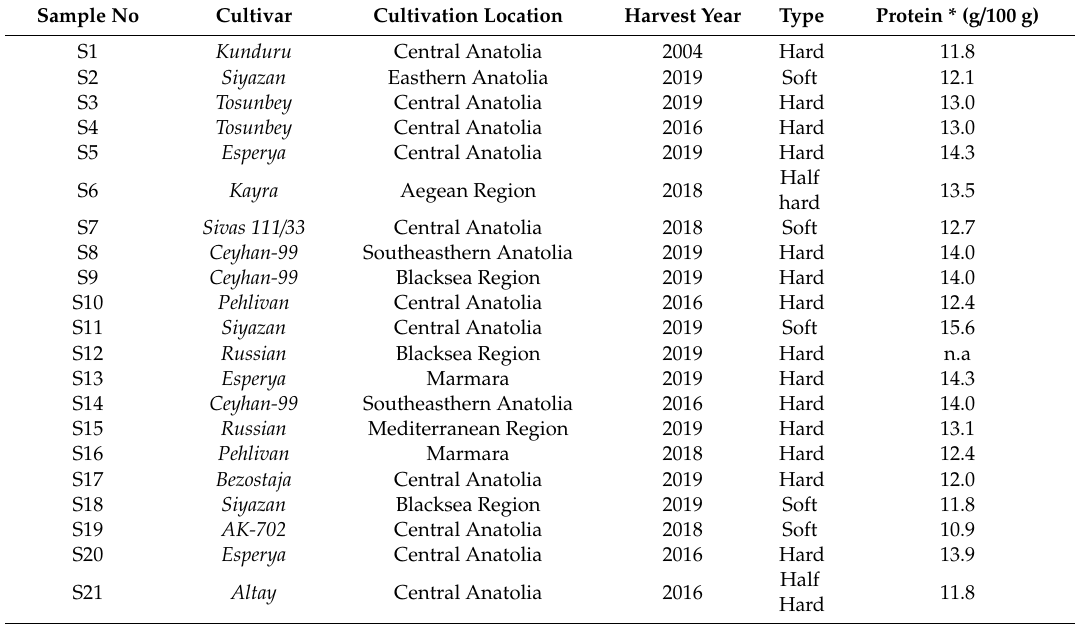
Table 2. Selected Turkish wheat cultivars and their available data for the protein comparison. Sample No Cultivar